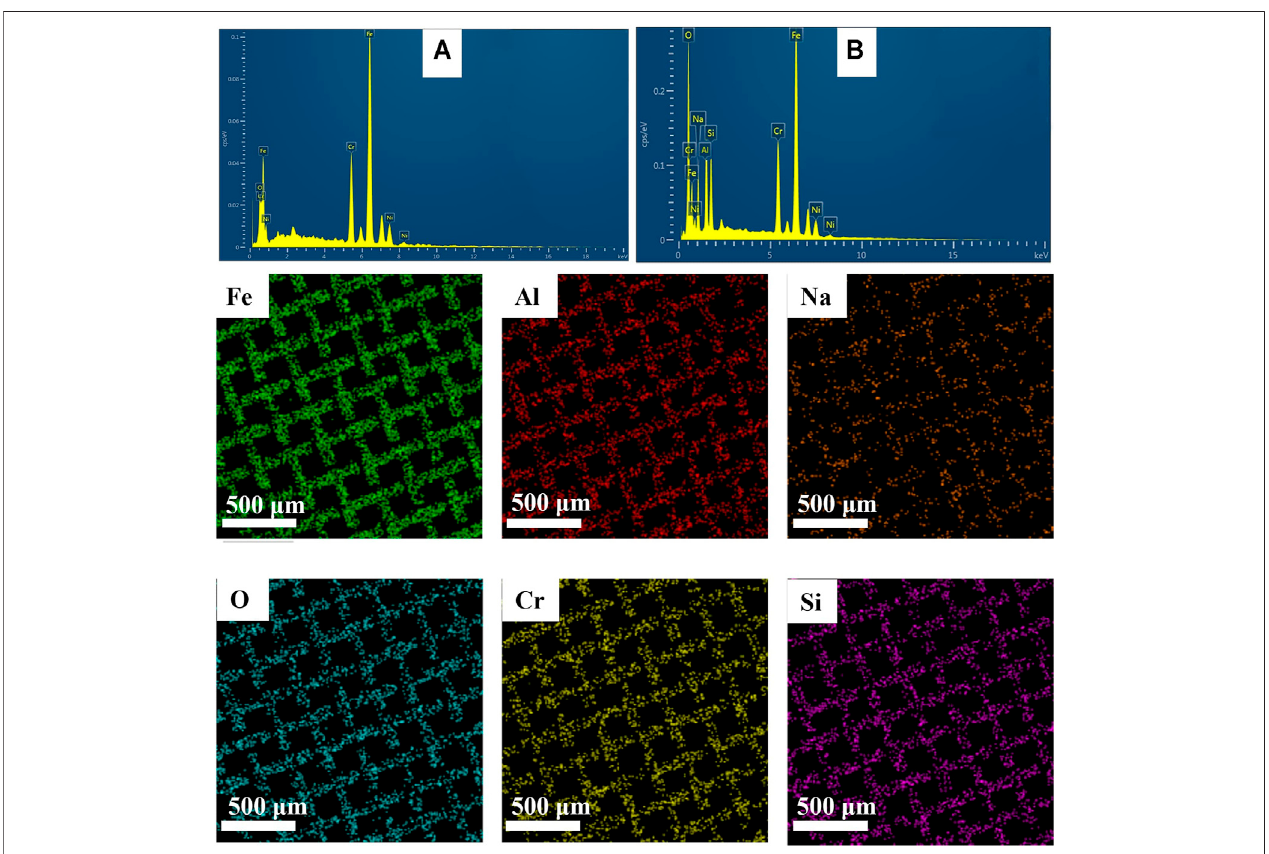
FIGURE 5 | Energy-dispersive X-ray (EDX) spectra and color mapping of pristine and sodium zeolite-coated SS mesh.